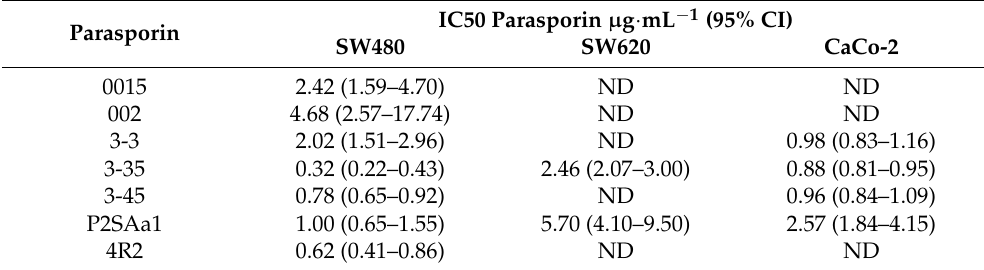
Table 2. Cytocidal activities of PS2Aa1 variants in human colorectal cancer cells.